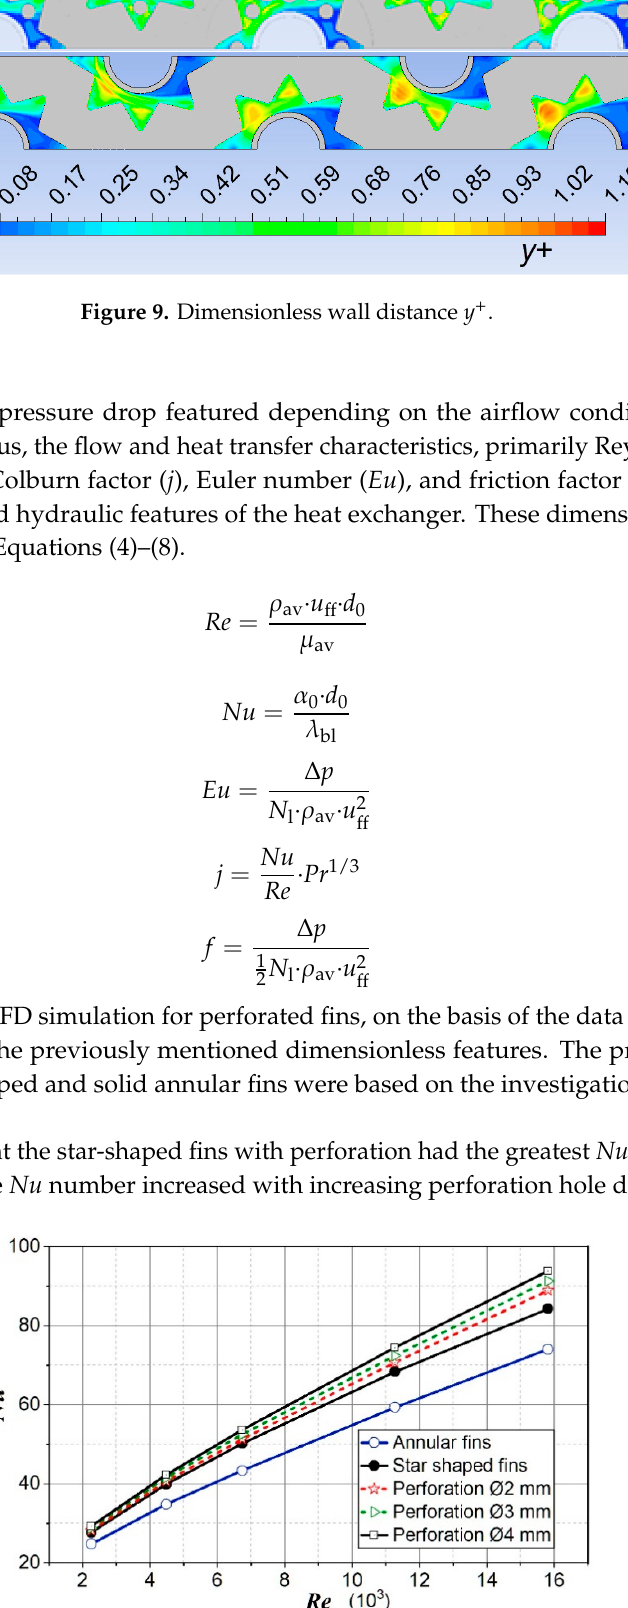
Figure 11. Heat transfer coefficient for analyzed cases. The influence of perforation on the Eu number was small in the whole area of the observed Re numbers (Figure 12). Moreover, at higher airflow speeds, the flow resistances of the tubes and fins